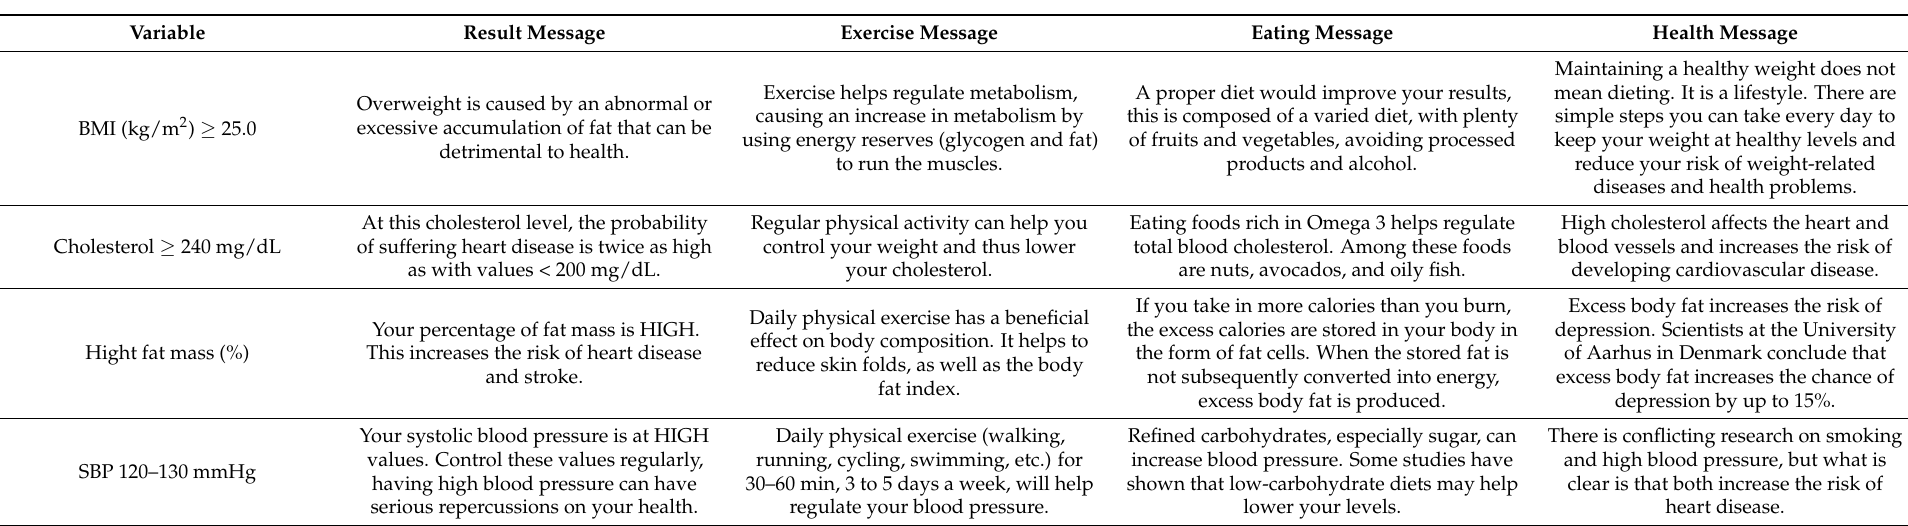
Table 2. Examples of application